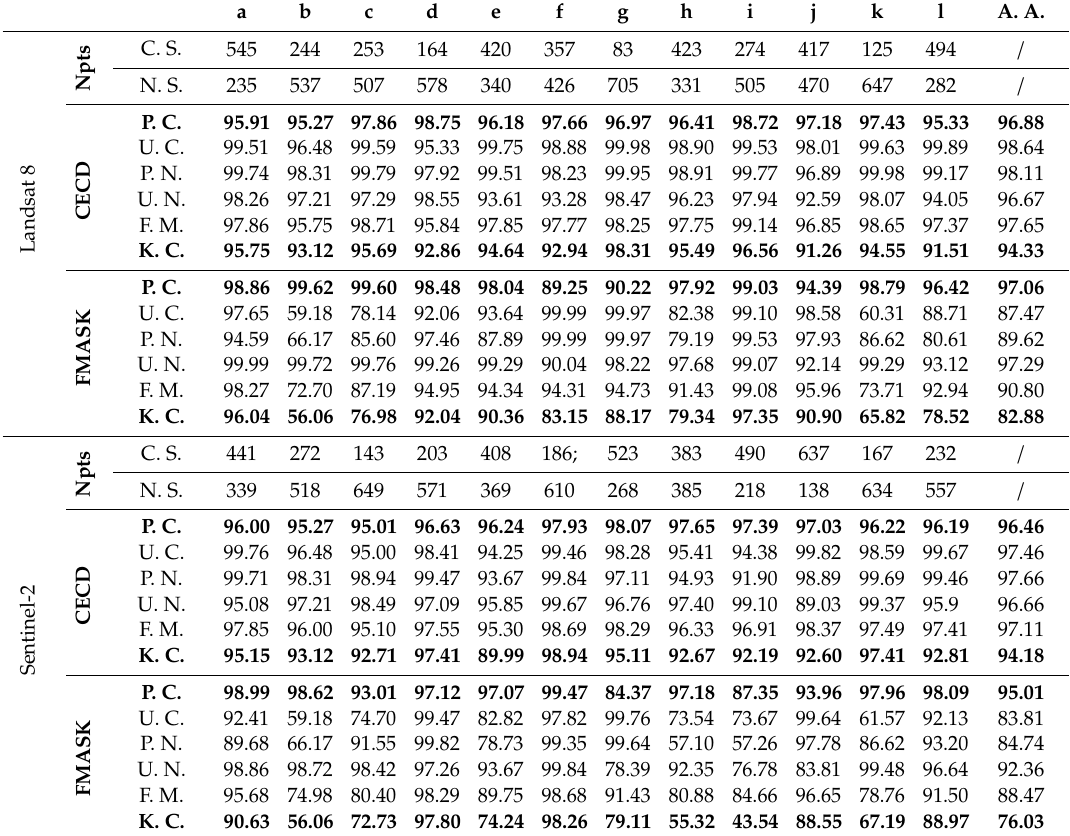
Table 3. Accuracy assessment results for CECD and function of mask (FMASK) based on the application of these methods to the Landsat-8 and Sentinel-2 scenes at the 12 test sites